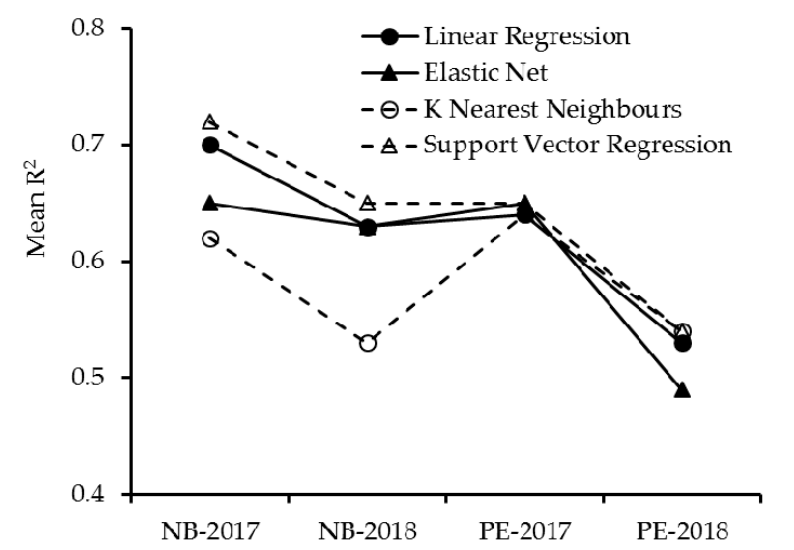
Figure 4. Comparative analysis of different datasets and machine learning algorithms.